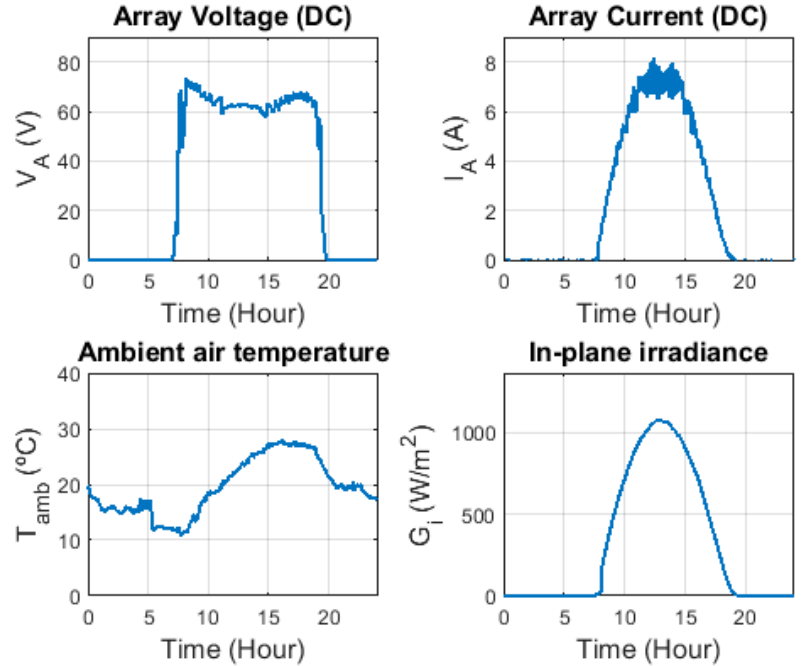
Figure 12. Monitored DC electrical parameters. Top, G i , T amb , V A and I A on a cloudy day. Bottom, V A and I A on a sunny day.